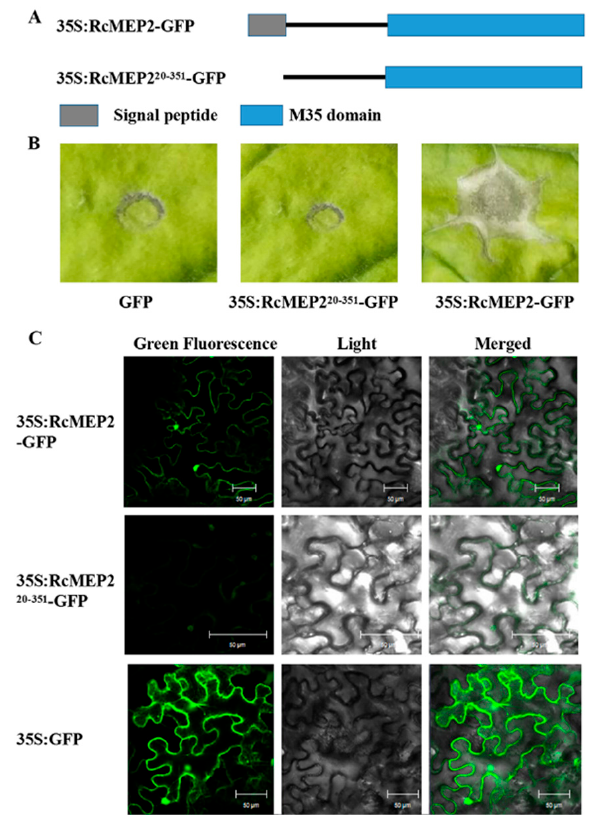
Figure 6. The signal peptide function and cell death-induced activity of RcMEP2 through Agrobacterium tumefaciens -mediated transient expression in N. benthamiana . ( A ) Scheme of RcMEP2-GFP and RcMEP2’s signal peptide-deleting-green fluorescent protein (GFP) expressing vectors, p35S:RcMEP2-GFP and p35S:RcMEP2 20-351 -GFP. ( B ) The plant cell death symptoms of the leaves agroinfiltrated by the indicated proteins. ( C ) Confocal microscopy images of 35S:RcMEP2-GFP, 35S:RcMEP2 20-351 -GFP, or 35S:GFP in these agroinfiltrated leaves of N. benthamiana . These GFP signals were observed under a confocal microscope. Bars = 50 µM.